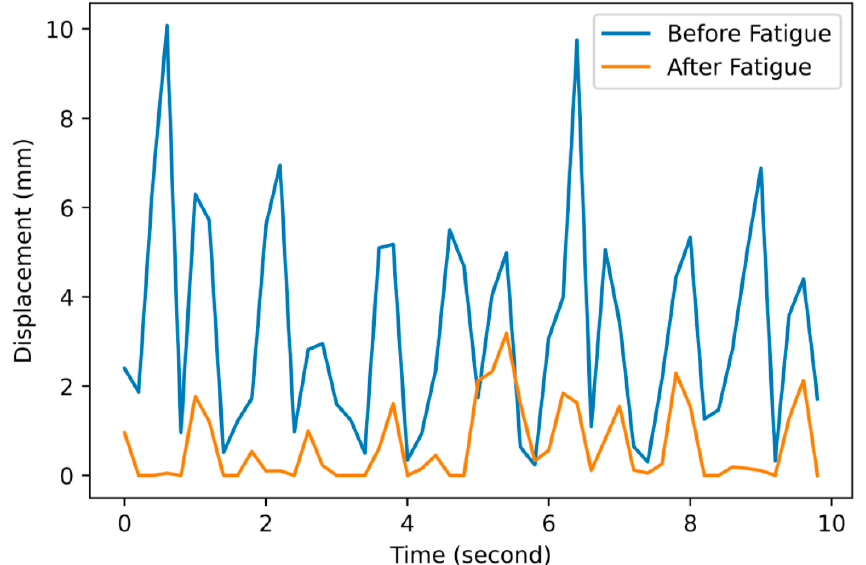
Figure 5. Illustration of detected stimulation responses (displacement) before and after fatiguing trial.